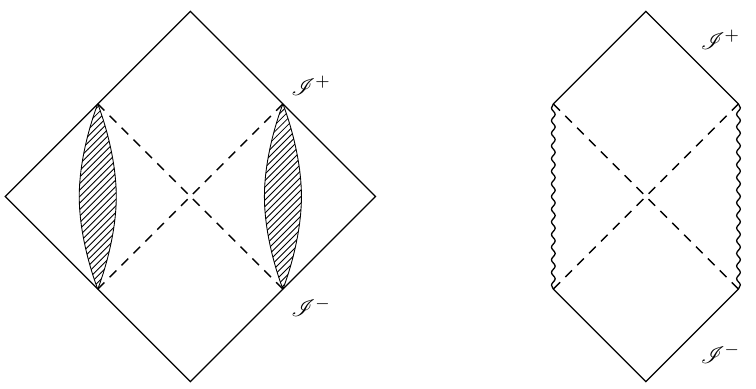
Figure 3 . Projection diagram of the warped (cid:13)at quotient in the case where closed timelike curves are present ! (cid:20) (cid:0) (cid:24)= 2. The closed timelike curves appear in the shaded region in the left picture: p p (cid:0) ! (cid:0) (cid:0) (cid:24) ( (cid:24) + 2 ! ) < (cid:26) < (cid:0) ! + (cid:0) (cid:24) ( (cid:24) + 2 ! ). In the right picture we have cut o(cid:11) the